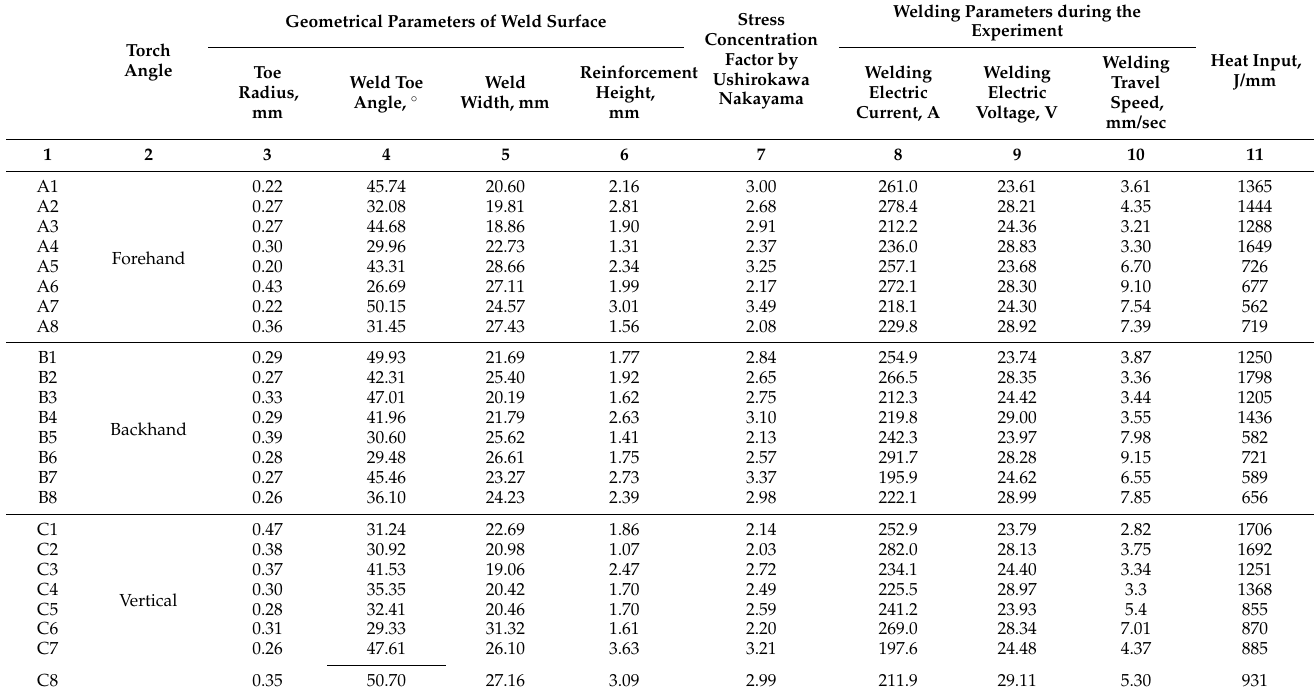
Table 4. Experimental results.